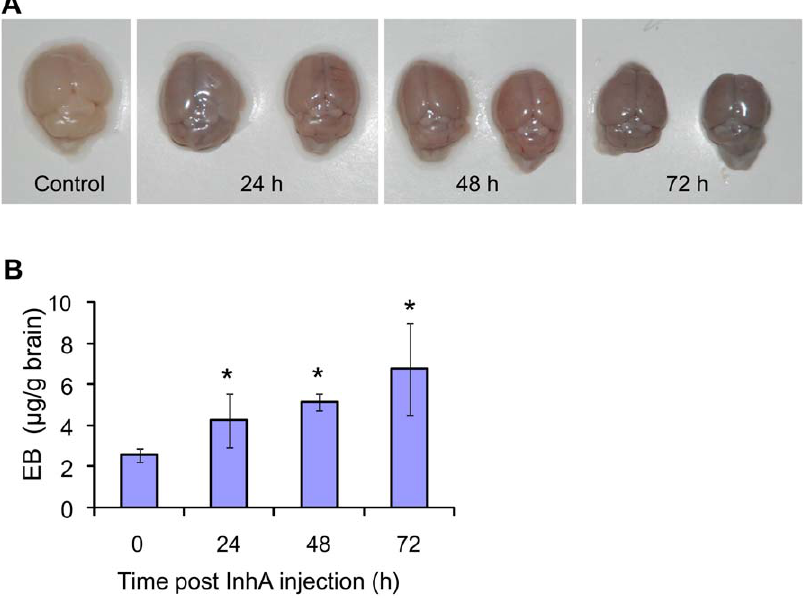
Figure 4. EB extravasation in the brains of InhA-challenged mice. Brain vascular permeability was measured using EB dye extravasation from whole mouse brains after challenge with InhA through retro-orbital injection. (A) Representative pictures of mouse brains at indicated time points. (B) Quantitation of the EB dye extravasation in the brain. The mean 6 SD are presented as m g of EB dye per gram of brain ( n =5 in the InhA-injected groups; n =3 in the control group). * P , 0.05 vs. control group.